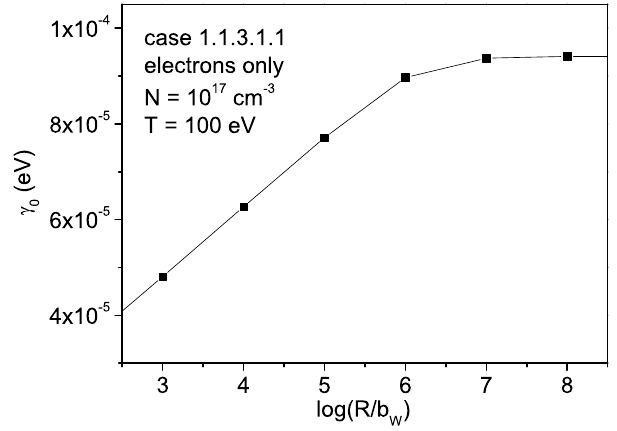
Figure 2. The collision operator at the line center ( ∆ ! = 0 ) is a weakly increasing function of the box size R and saturates when R is of the order of 10 8 . This roughly corresponds to the value of v / (cid:22) (cid:13) (see